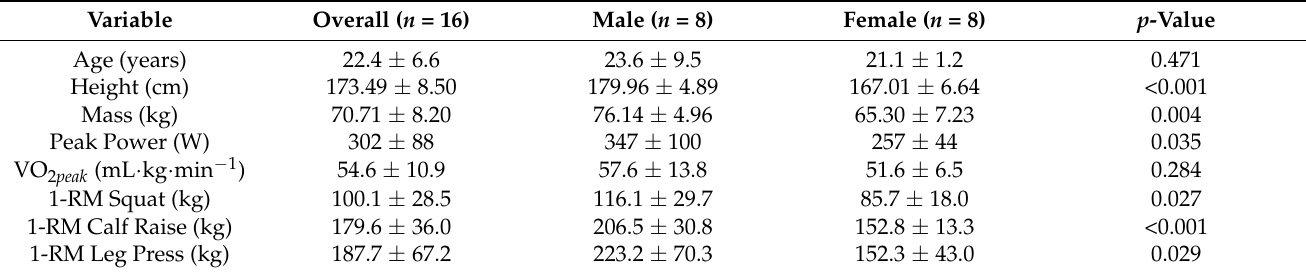
Table 1. Participant characteristics (Mean ±